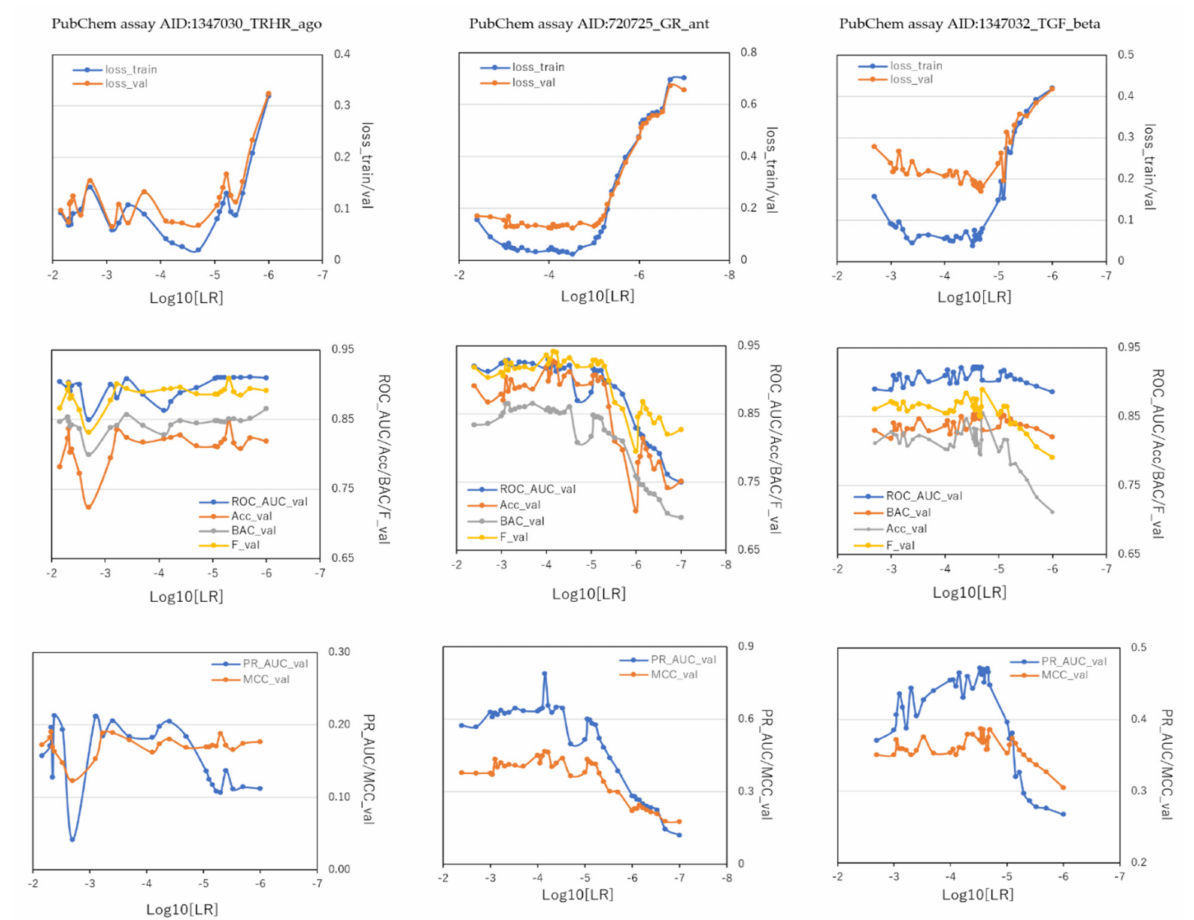
Figure 5. Performance contribution of learning rates (LRs) in DeepSnap − DL using TensorFlow of prediction models of the glucocorticoid receptor (PubChem assay AID:720725_GR_ant), TGF- beta/Smad (PubChem assay AID:1347032_TGF_beta_ant), and agonist of the thyrotropin-releasing hormone receptor (PubChem assay AID:1347030_TRHR_ago) in the validation dataset; n =